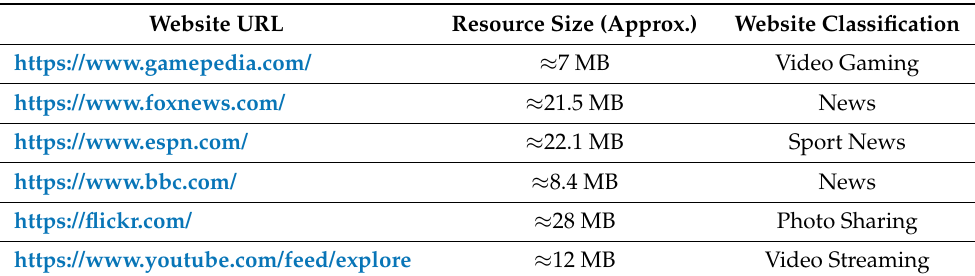
Table 2. List of the websites